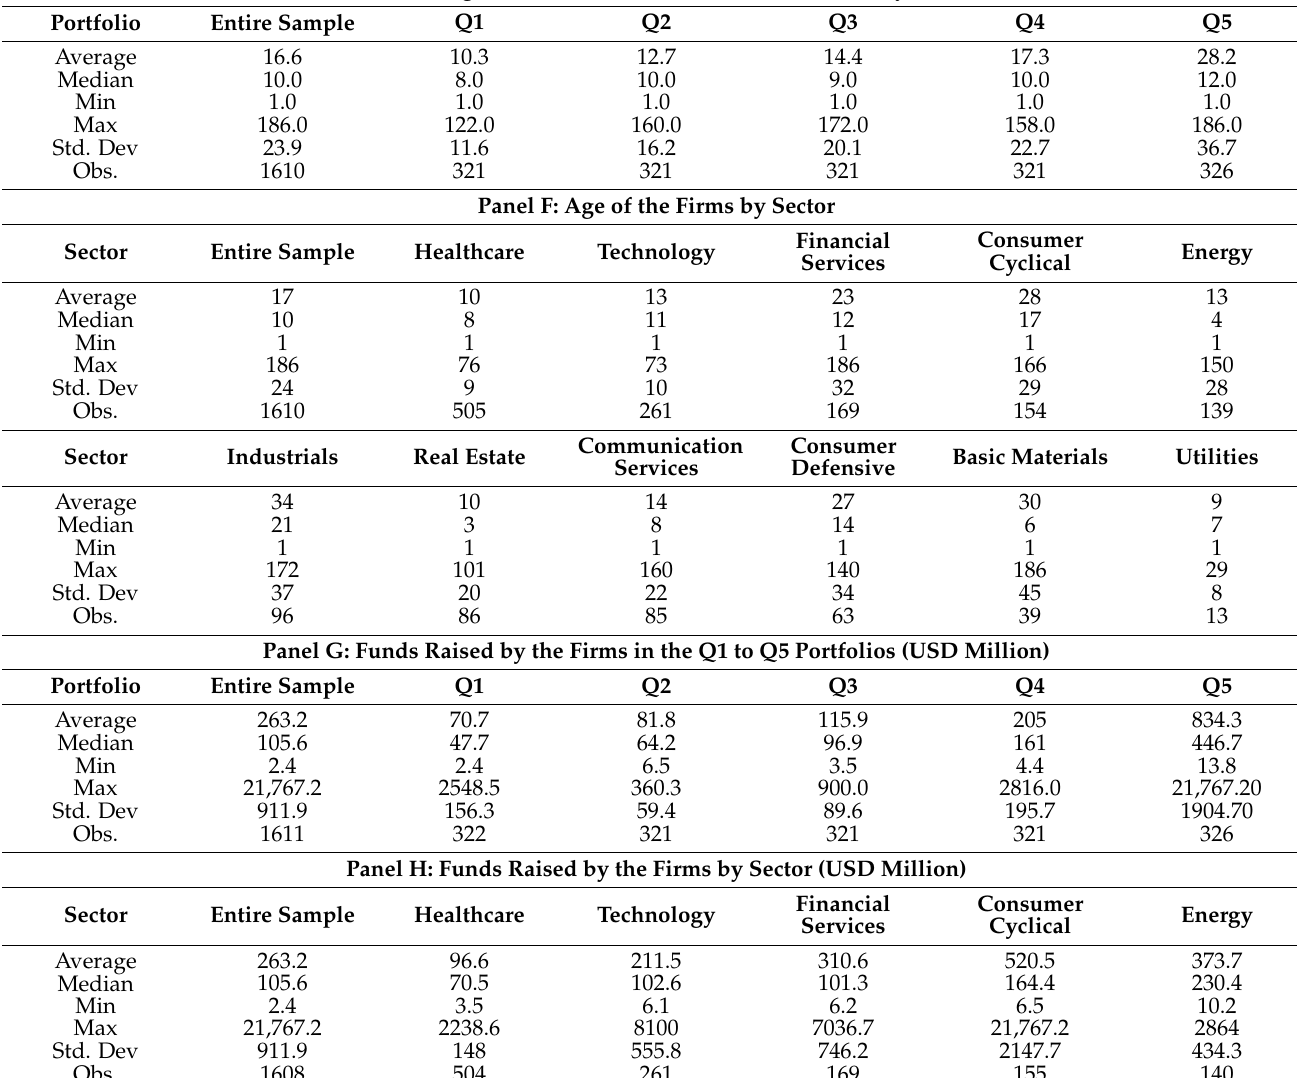
Table 1. Cont. Panel E: Age of the Firms in the Q1 to Q5 Portfolios (years)